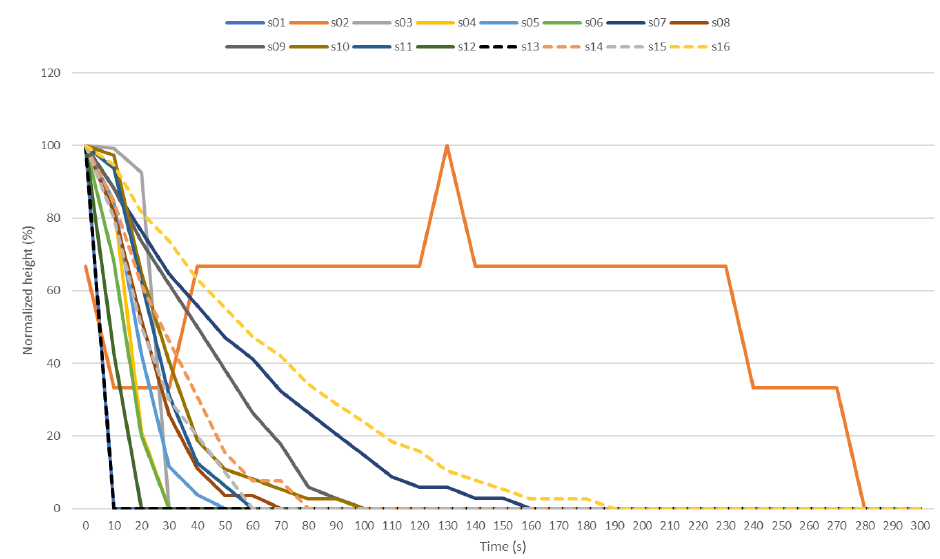
Figure 7. A normalized distance of beer foam (%) from 3D camera for 16 beer samples.